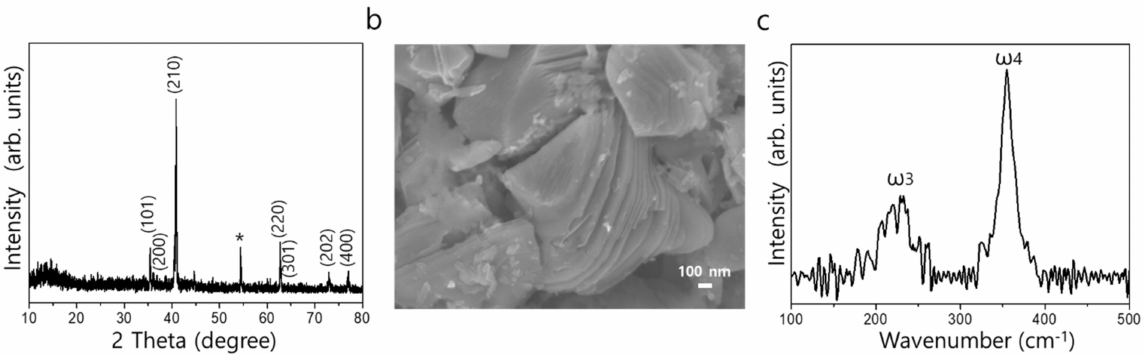
Figure 3. ( a ) XRD pattern, ( b ) FE–SEM image, ( c ) Raman spectrum of the layered Ti 2 N MXene